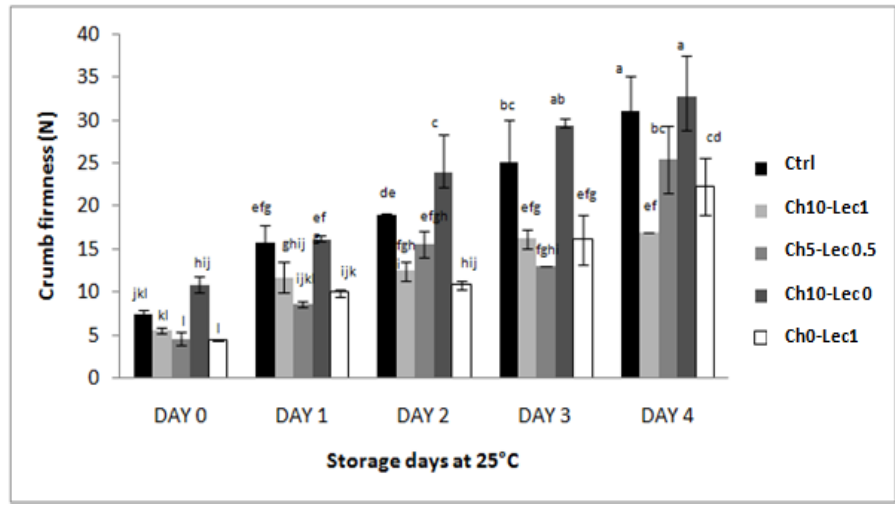
Figure 2. Crumb firmness of the different formulations during storage at 25 °C. N, Newton. a–l: Bars followed with the same letter are not significantly di ff erent at p <